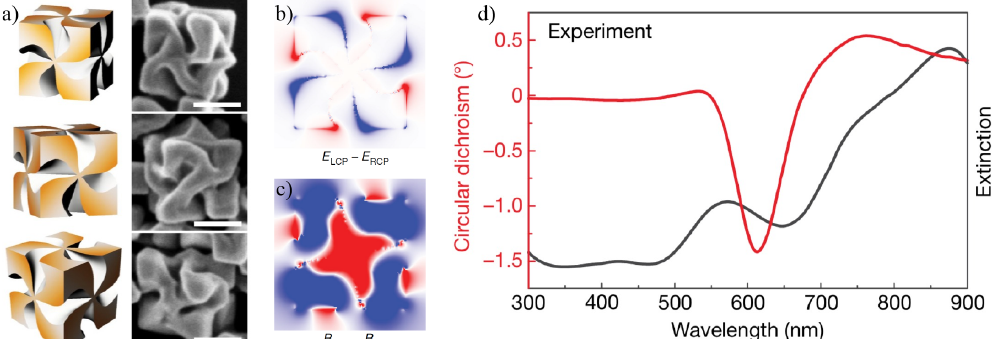
Figure 4. ( a ) Different three-dimensional perspectives (left) and SEM images (right) of a chiral plasmonic nanoparticle evolved from an octahedral seed. ( b ) Differential electric ( E ) and ( c ) magnetic B near-fields after successive illumination with LCP and RCP incident light. ( d ) Experimental results for CD (red) and extinction (black) spectra. Reproduced with permission from ref. [69]. Copyright 2018 Springer Nature.